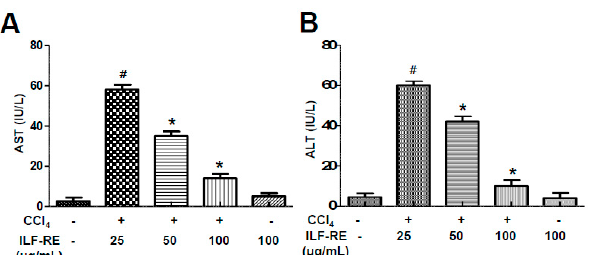
Figure 1. ILF-RE protects against CCl 4 -induced hepatic damage. Primary hepatocytes were treated with 25, 50, and 100 μ g/mL of ILF-RE dissolved in water and incubated with 20 mM CCl 4 for 6 h. Aspartate transaminase (AST) ( A ) and alanine transaminase (ALT) ( B ) activity were determined in hepatocyte primary cells. Data are expressed relative to the controls ( n = 3; # p < 0.05 vs. Con; * p < 0.05 vs. CCl 4 ). Con, control; CCl 4 , carbon tetrachloride; ILF-RE, the combination R. verniciflua with E. ulmoides .